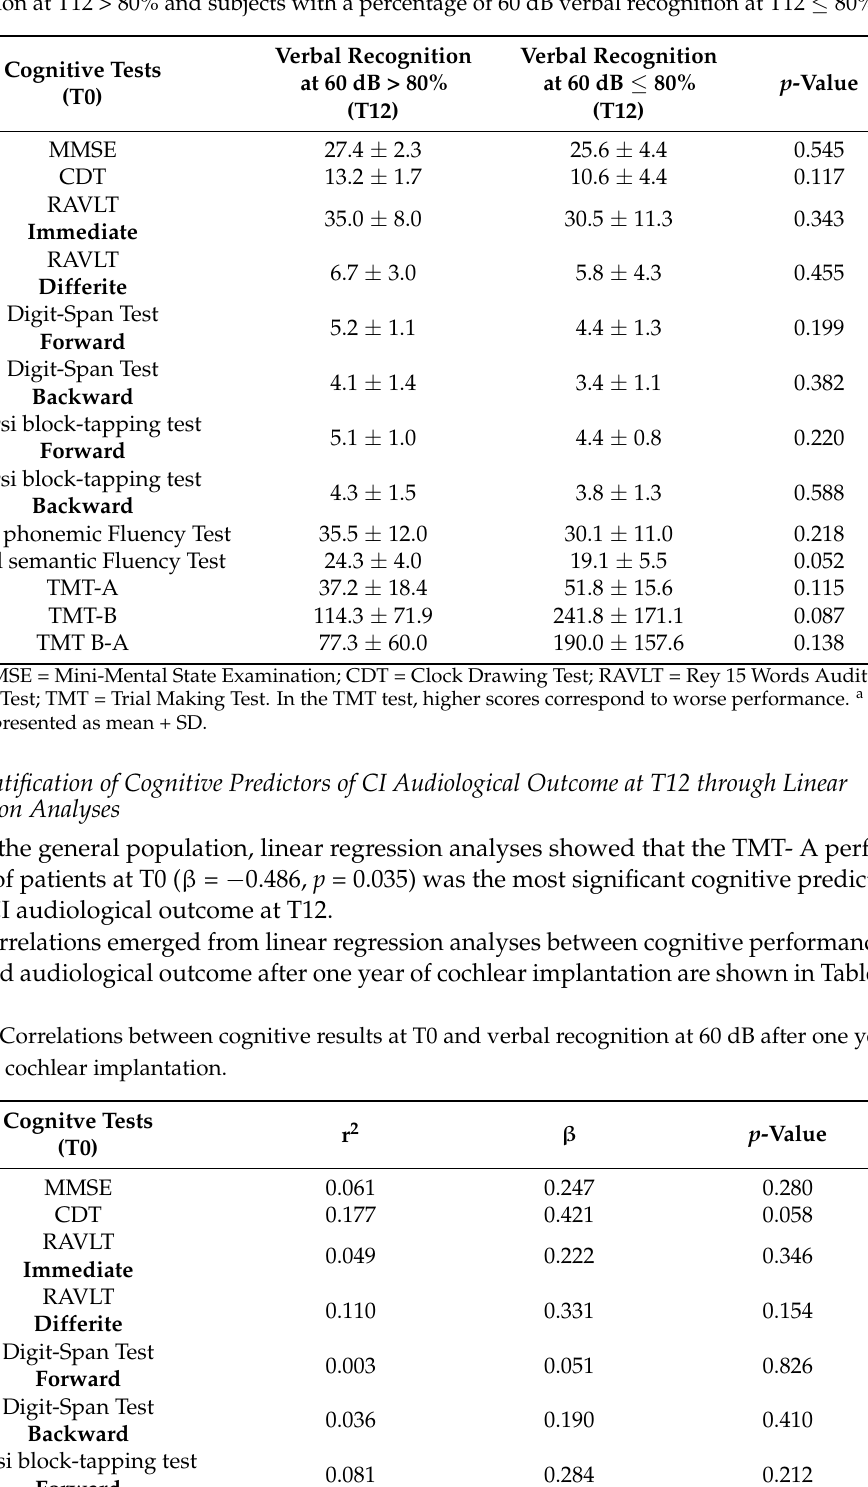
Table 3. Difference of cognitive results at T0 between patients with a percentage of 60 dB verbal recognition at T12 > 80% and subjects with a percentage of 60 dB verbal recognition at T12 ≤ 80% a .